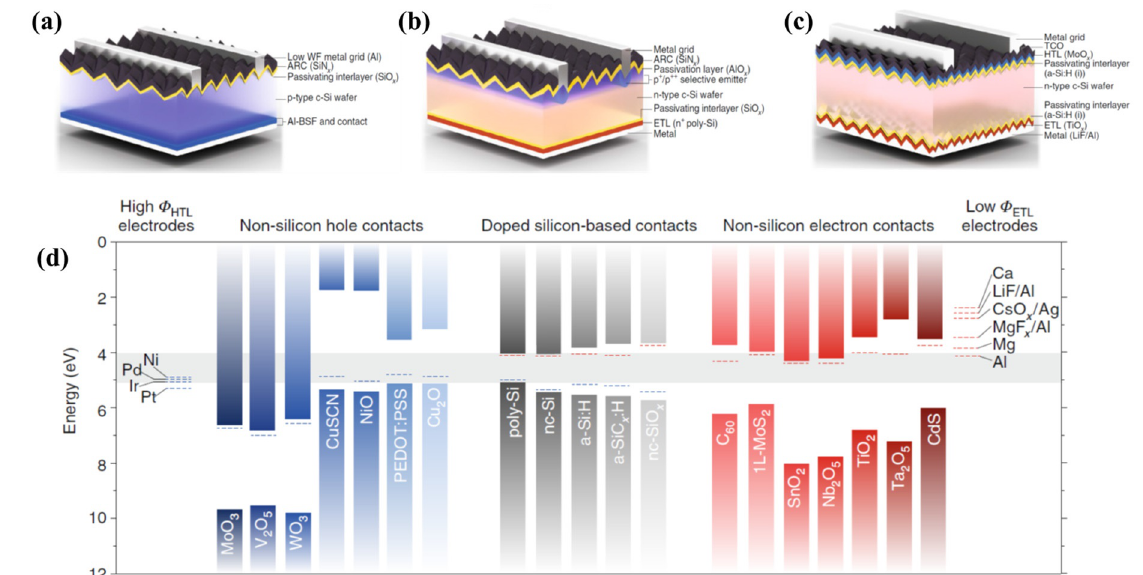
Figure 6. Solar cells featuring passivating contacts. ( a ) Hybrid metal–insulator–semiconductor (MIS) cell; ( b ) electron tunnel-oxide passivating contact (TOPCon) solar cell; ( c ) dopant-free asymmetric heterocontact (DASH) solar cell; ( d ) materials for passivating contacts. Reprinted with permission from ref. [20]. Copyright 2019 Springer Nature.